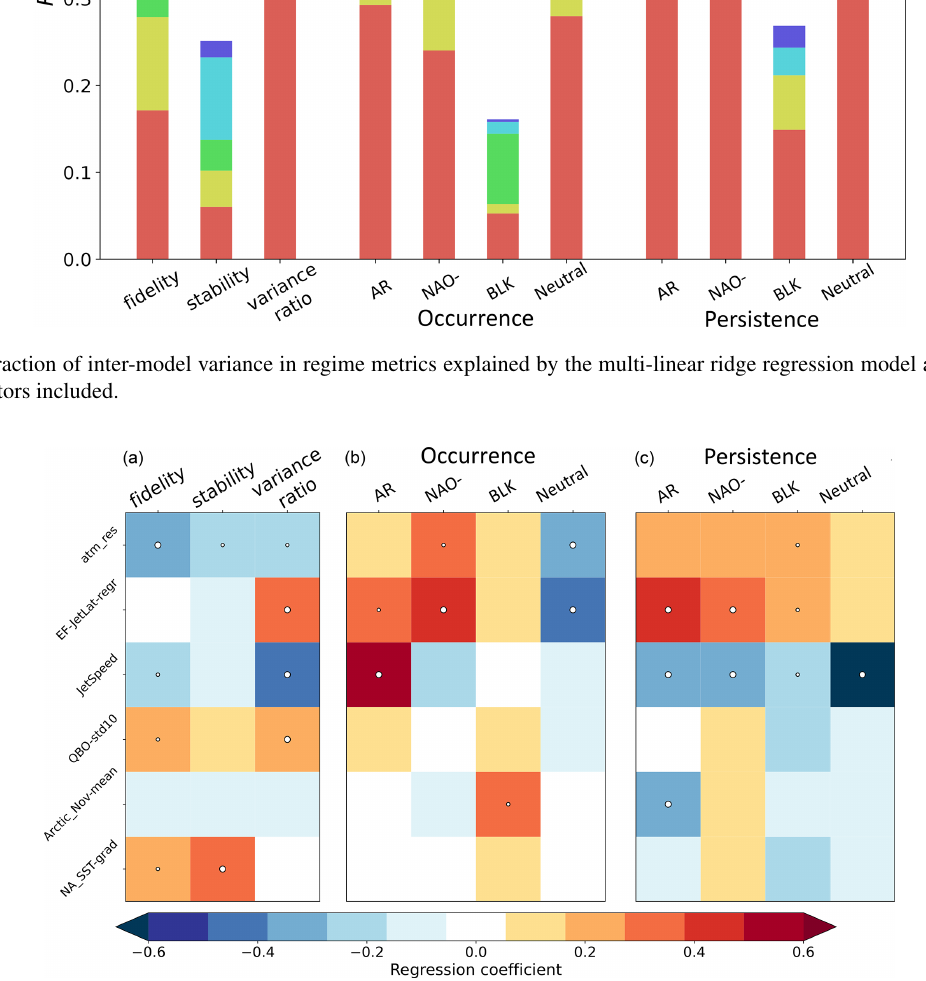
Figure 14. Regression coefficients from the six-predictor multi-linear ridge regression model, trained on CMIP5, CMIP6, and HighResMIP models, for spatial regime representation (a) , regime occurrence fractions (b) , and regime persistence probabilities (c) . Where the explanatory power of a predictor for a metric is significant at the 95th (99th) percentile, it is marked with a small (large)